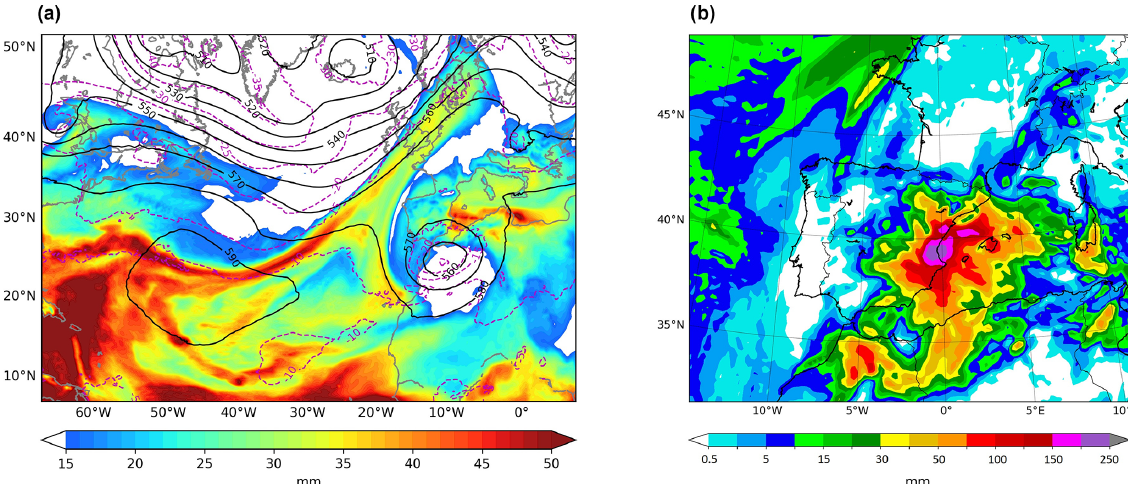
Figure 2. (a) Synoptic situation (from WRF simulation) on 20 October 1982 at 12:00UTC. Geopotential height (solid black contours, dam) and temperature at 500hPa and total precipitable water (shades, mm). (b) Simulated total precipitation (mm) from 19 October at 06:00UT to 22 October at 06:00UTC (Insua-Costa et al.,